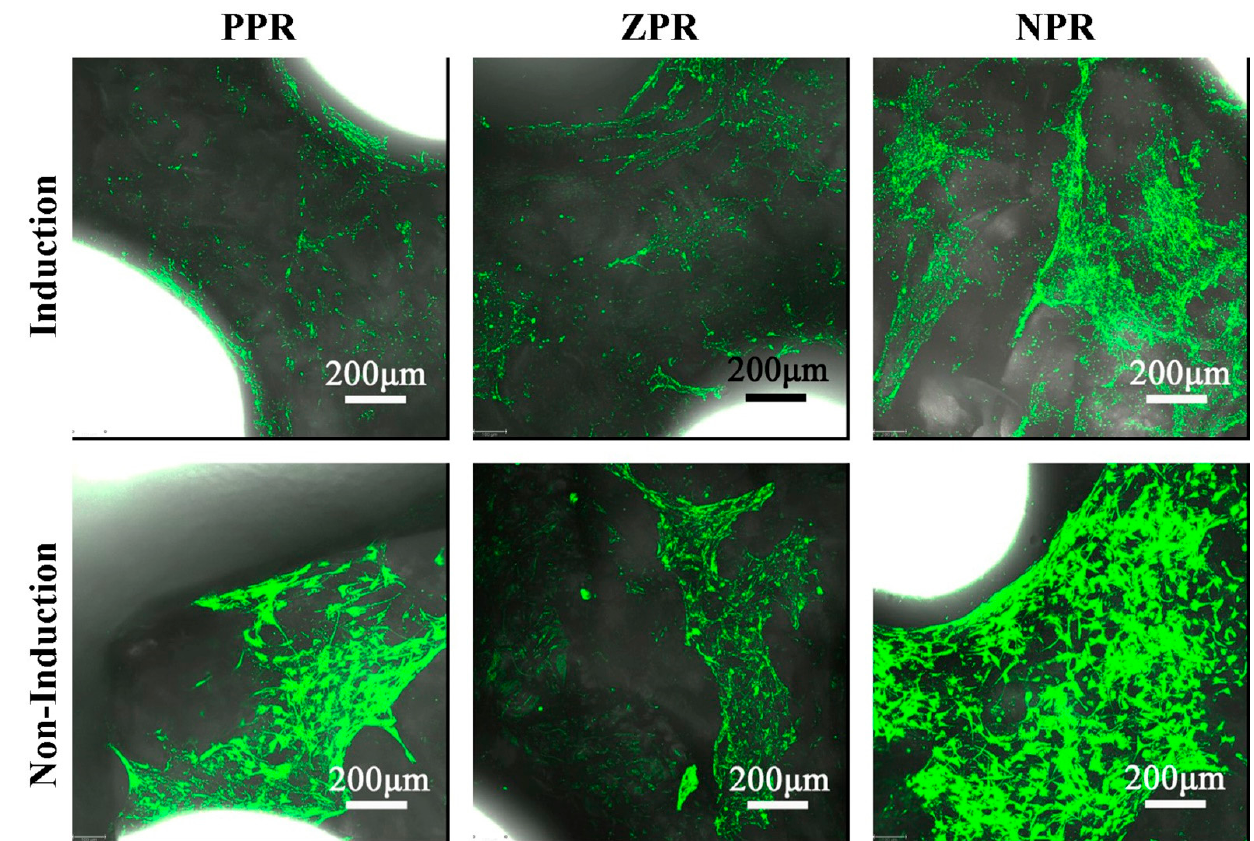
Figure 7. CLSM of mBMSCs induced on CNF/PEGDA scaffolds for 3 weeks.